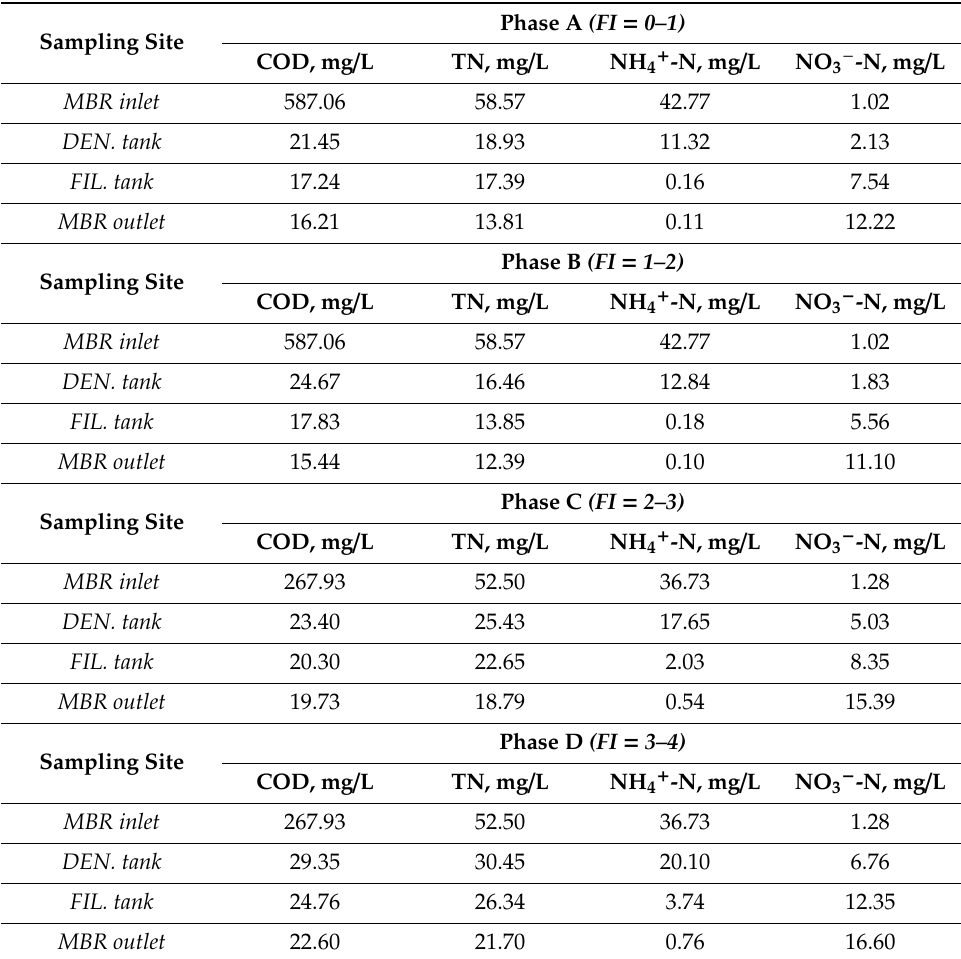
Table 3. E ffl uent quality parameters for all phases in the pilot-scale